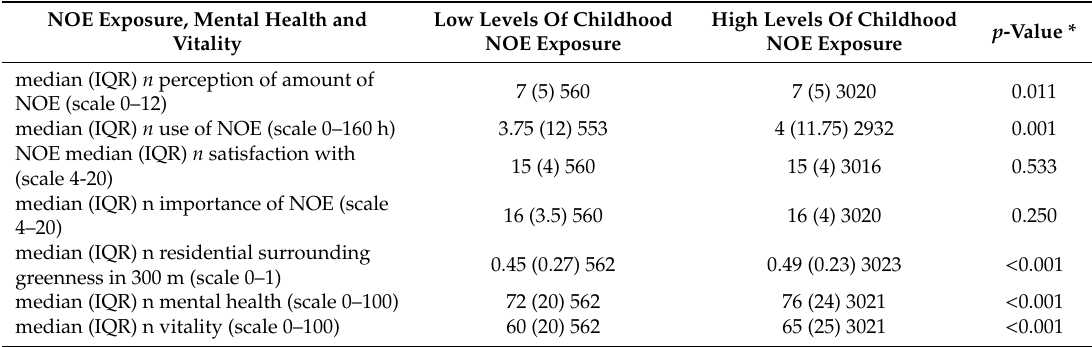
Table 6. NOE exposure, mental health and vitality of the study population on pooled level for subgroups with di ff erent amount of childhood NOE exposure (low levels and high levels).